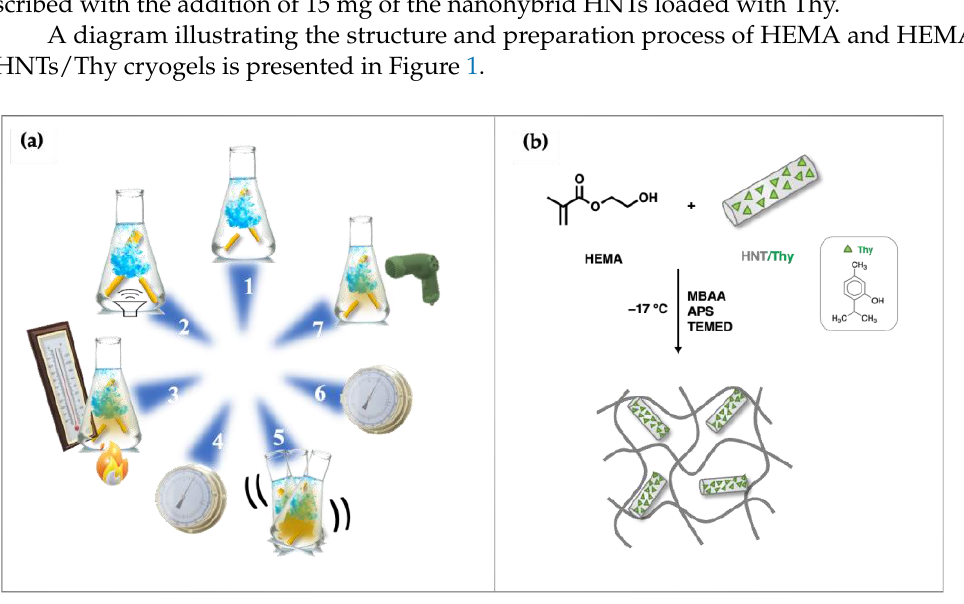
Figure 1. Schematic representation of ( a ) HTNs/Thy preparation: (1) Dissolution; (2) Mix; (3) Heating; (4) Vacuum; (5) Shaking; (6) Vacuum; (7) Drying. ( b ) Cryogel synthesis.